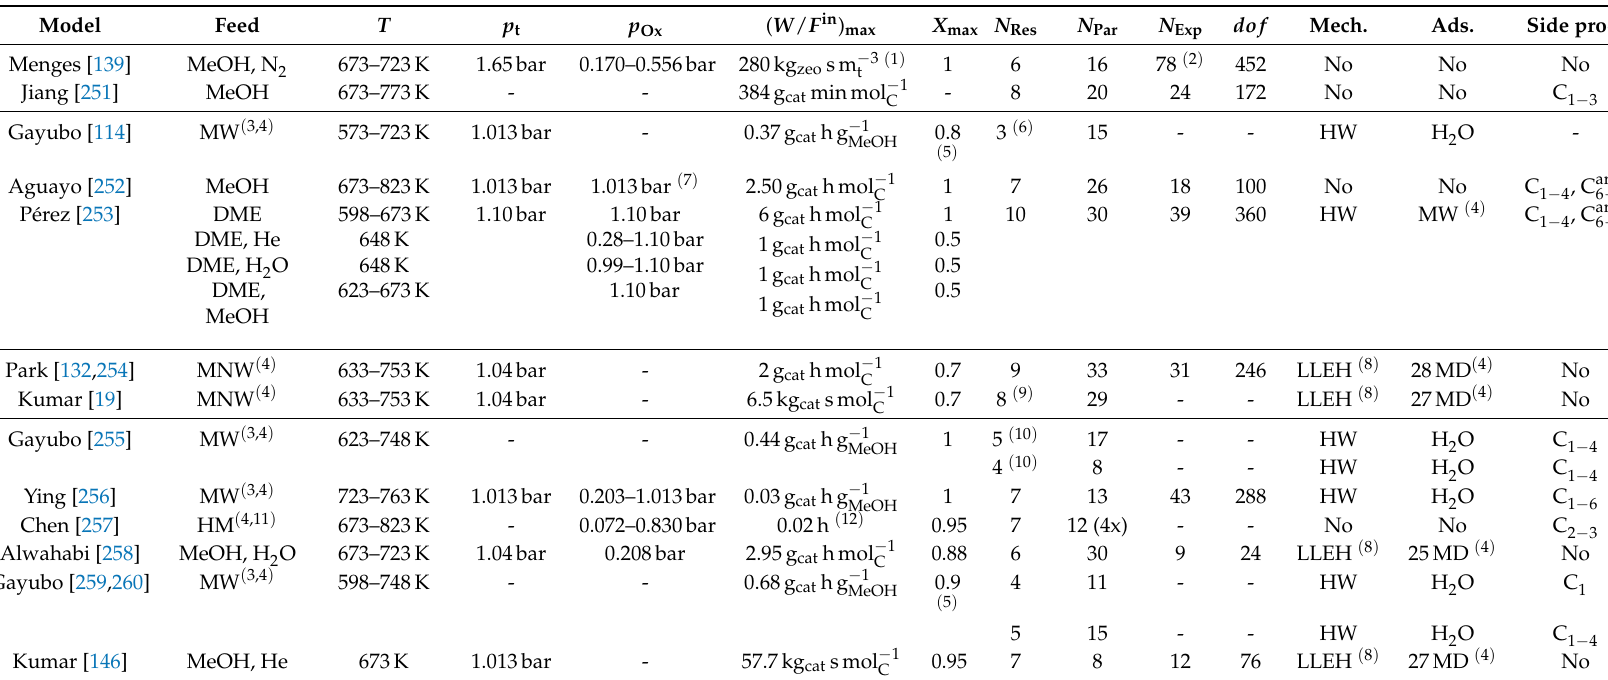
Table 4. Experimental conditions and modeling details for the kinetic models of methanol-to-olefins without olefin co-feed; the feed components, the temperature range ( T ), the total pressure ( p t ), the partial pressure range of the feed oxygenates ( p Ox ) and the maximum contact time (( W / F in ) max ) with resulting oxygenates conversion ( X max ) are listed; concerning the model, the number of fitted responses ( N Res ), the number of estimated parameters ( N Par ), the number of experiments ( N Exp ) and the degree of freedom ( dof ) are shown; and, finally, it is noted whether the model follows a type of a mechanistical scheme (Mech.), whether adsorption is considered (Ads.) and which side products are included (Side prod.). The line separates the different subsections. A hyphen represents missing